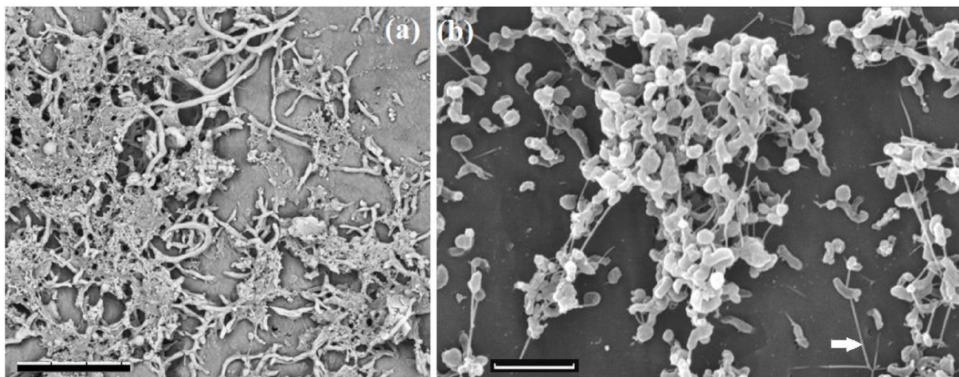
Figure 5. Scanning electron micrographs of biofilms of a sulfate-reducing enrichment obtained from the near-bottom zone of injection well ( a ) and of the Desulfovibrio alaskensis Kaz19 ( b ) grown in lactate-sulfate medium for 14 days. Morphological diversity of cells embedded into exopolymers in biofilms-producing enrichment culture ( a ) and pilus-like nanowires which connect the cells of D. alaskensis Kaz19 ( b ) can be seen. The images were obtained under a scanning electron microscope TM3000 (Hitachi, Japan) (accelerating voltage 15 kV) ( a ) and under a scanning electron microscope Camscan-S2 (Cambridge, UK) (accelerating voltage 20 kV, SEI mode) ( b ). Arrow indicates the pilus-type nanowires that touch both the surface and other cells. Scale bars, 10 µ m ( a ), 3 µ m ( b